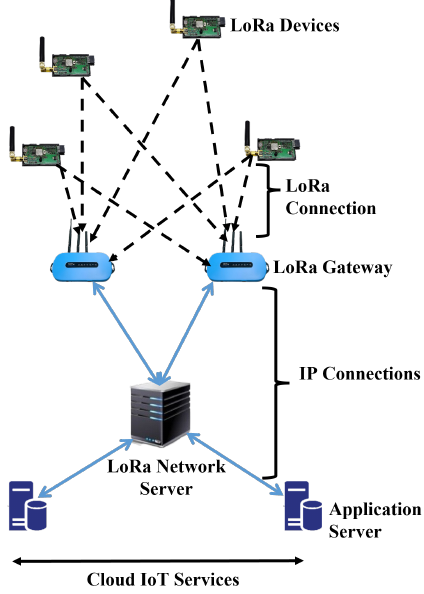
Figure 1. General network architecture for IoT LoRa